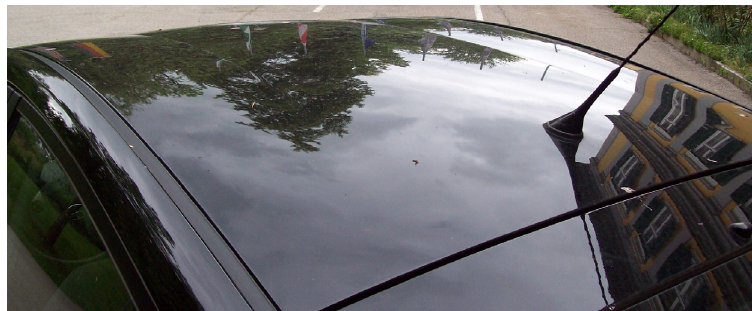
Figure 2. Curved shape of the roof of a Toyota Prius. Table 1. Longitudinal angles of PV cells on the roof of a Toyota Prius.